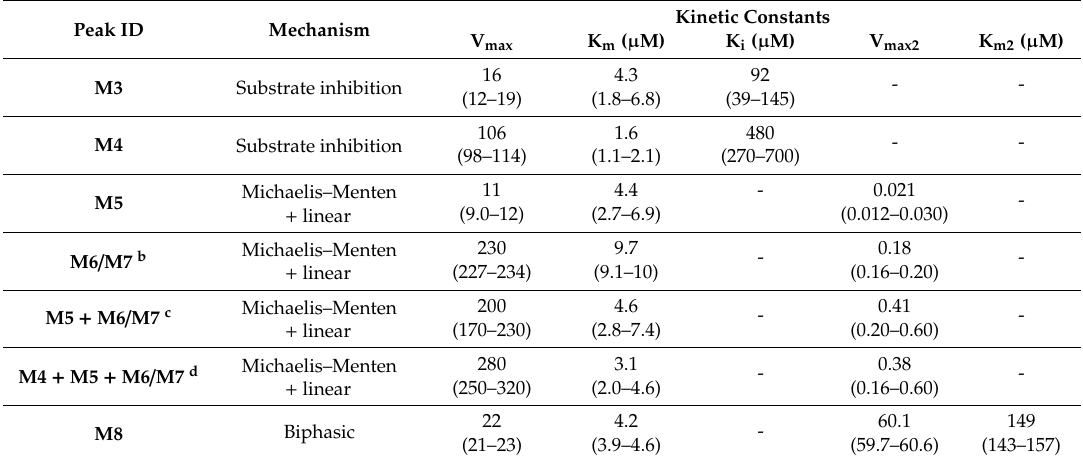
Table 2. Steady-state kinetics for 5F-APINACA metabolism by human liver microsomes a